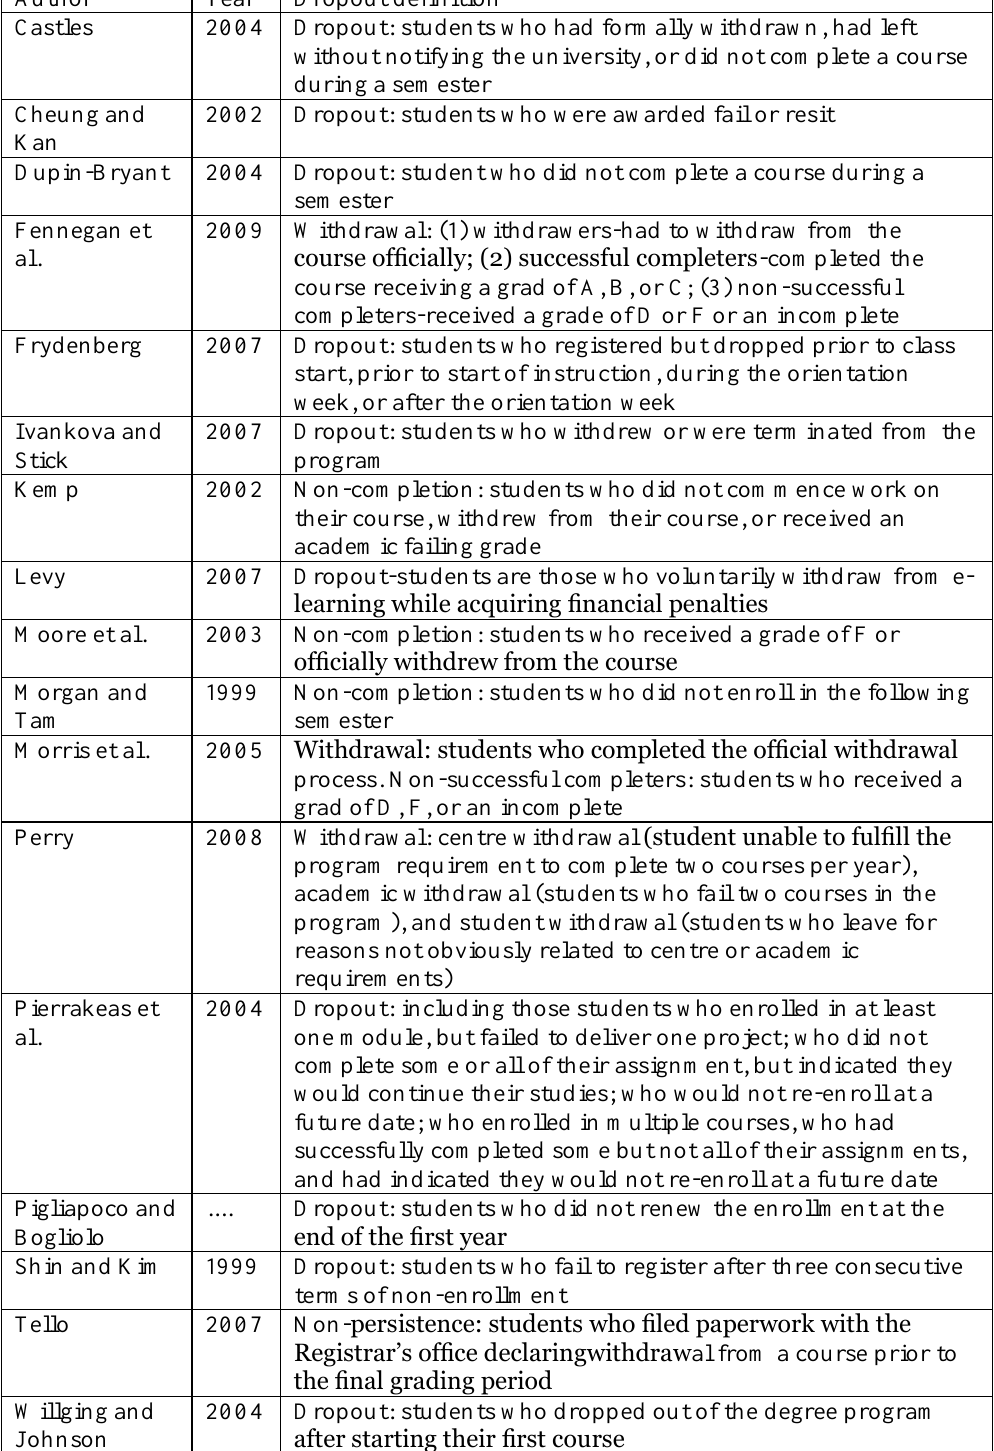
Table 1 Heterogeneity of Dropout Definitions (Extracted from Lee & Choi,